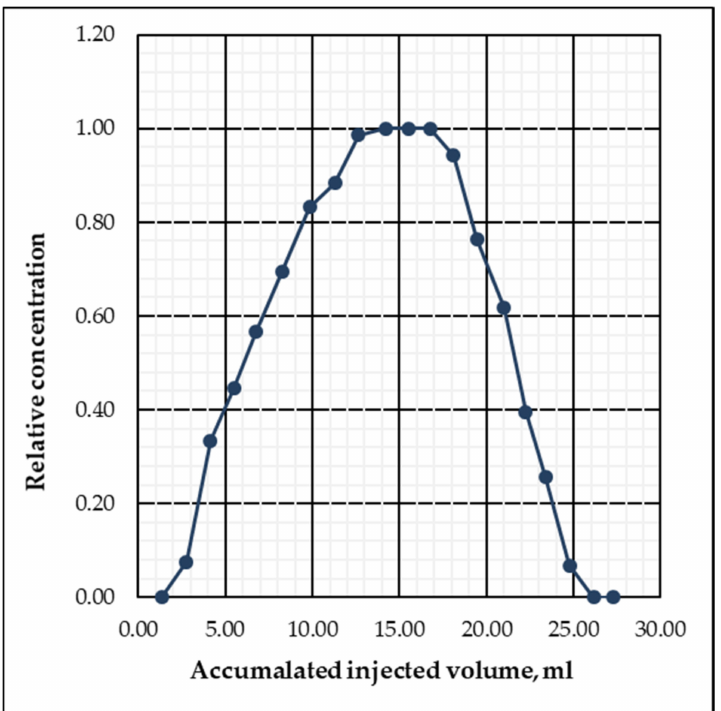
Figure 11. Dependency graph of relative concentration to the volume of liquid pumped for the solution